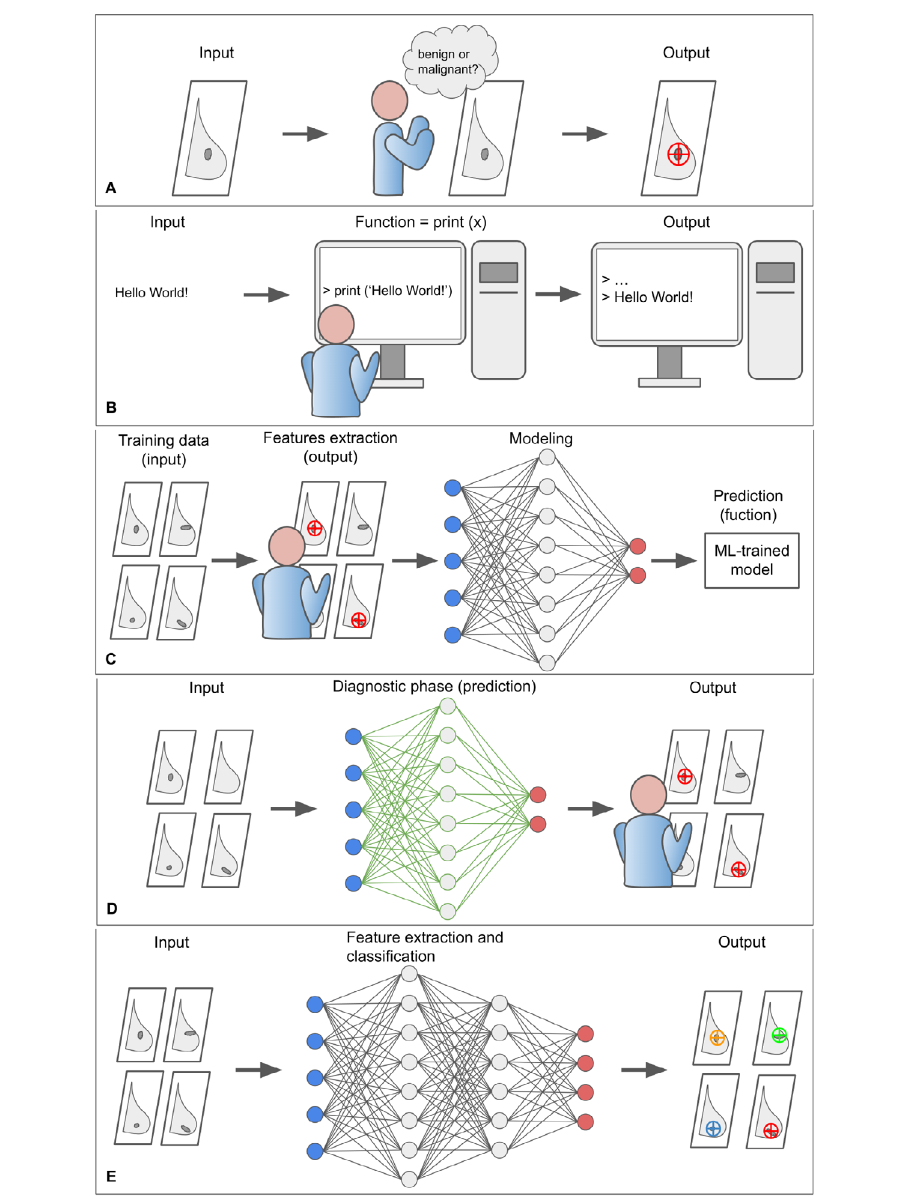
Figure 2. The core concepts of ML paradigm. A. In a normal workflow, the radiologist evaluates the mammogram (input) and determines whether the lesion is benign or malign (output); B. to program a computer to perform a certain operation, it is necessary to specify the function that the machine is to perform. In the example, the function—print (x)—writes the argument of the function to the screen. However, the extremely complex cognitive process of the radiologist cannot be translated into the programming language; C. the classification problem can be addressed through a ML approach. The proposed example is a form of supervised learning that exploit a simple ANN to perform a binary classification task that consists in distinguishing between benign and malignant lesion on digital mammograms. The ML model requires a learning phase in which both raw data and exams already classified by the radiologist are provided. The learning phase of the model includes a training, validation, and testing phase, which are not represented for clarity. The model progressively reduces the uncertainty as it is exposed to more data samples and comes to approximate the “function” normally performed by the radiologis; D. after the ML algorithm has been trained and tested, it can be integrated into clinical practice and used to assist the radiologist in visual assessment; E. DL models exploit particularly complex neural networks to extract and analyse new and intricate image patterns (radiomic features) in large data sets that are usually not accessible to the human operator. ANN: artificial neural network; DL: deep